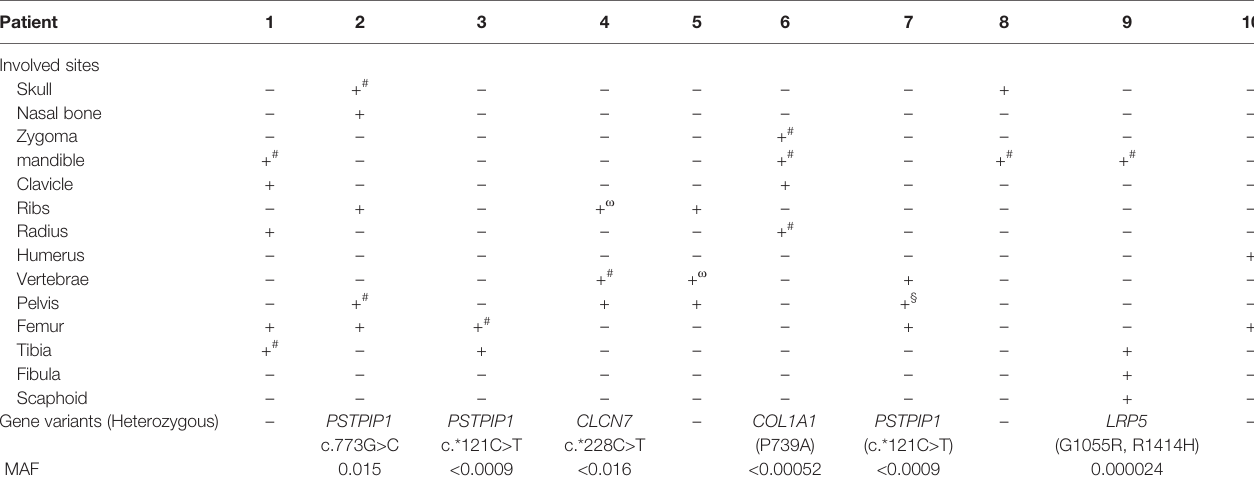
TABLE 2 | Characteristics of bone involvements and gene variants of Chinese adult patients with CNO.